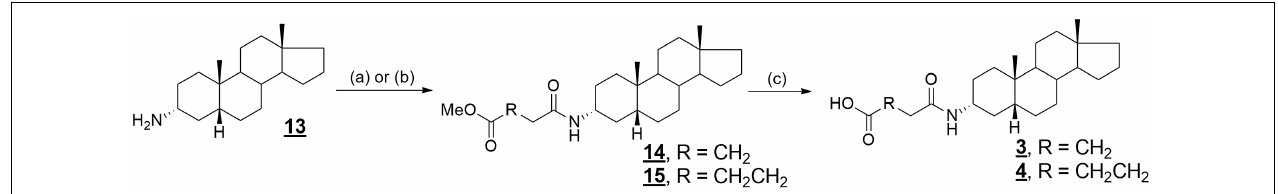
FIGURE 3 | Synthesis of compounds 3 and 4. Reagents and conditions: (a) ClCO(CH 2 ) 2 COOCH 3 , DIPEA, benzene, rt; (b) ClCO(CH 2 ) 3 COOCH 3 , DIPEA, benzene, rt; (c) NaOH, THF, H 2 O, rt.